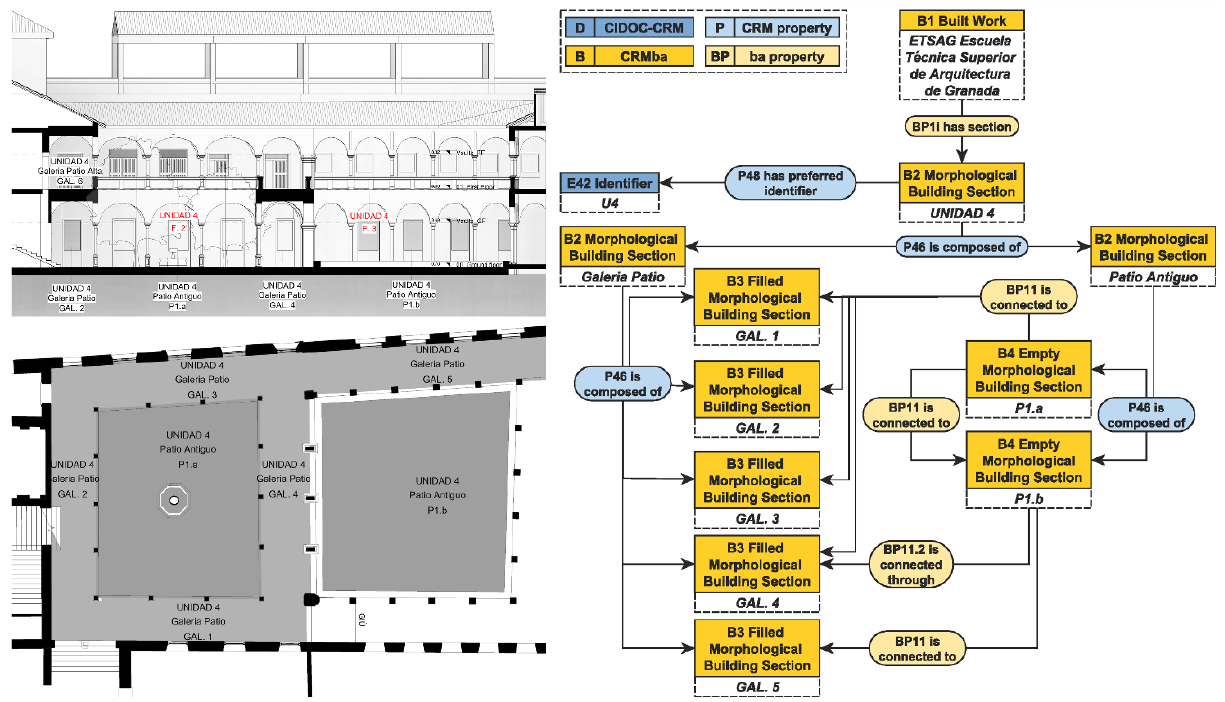
Figure 8. CRMba applied to UNIDAD 4 according with the Ground Floor Plan and Longitudinal